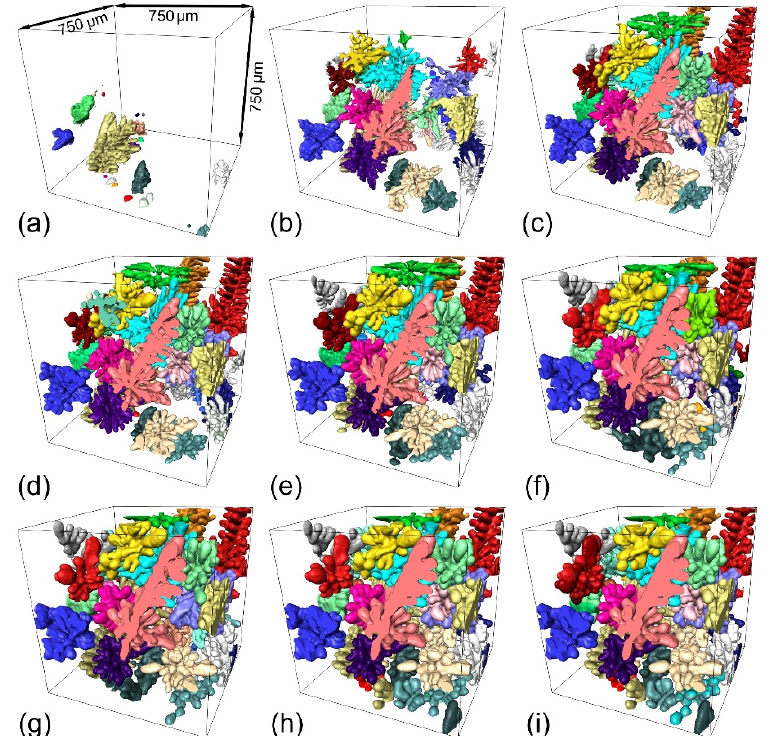
Figure 4. The growth and coarsening of Al-15 wt .% Cu alloy multiple dendrites at the solidification times of 10, 20, 30, 40, 60, 110, 160, 210, and 300 s as shown in ( a – i ) (see Video S1 for the growth dynamics).